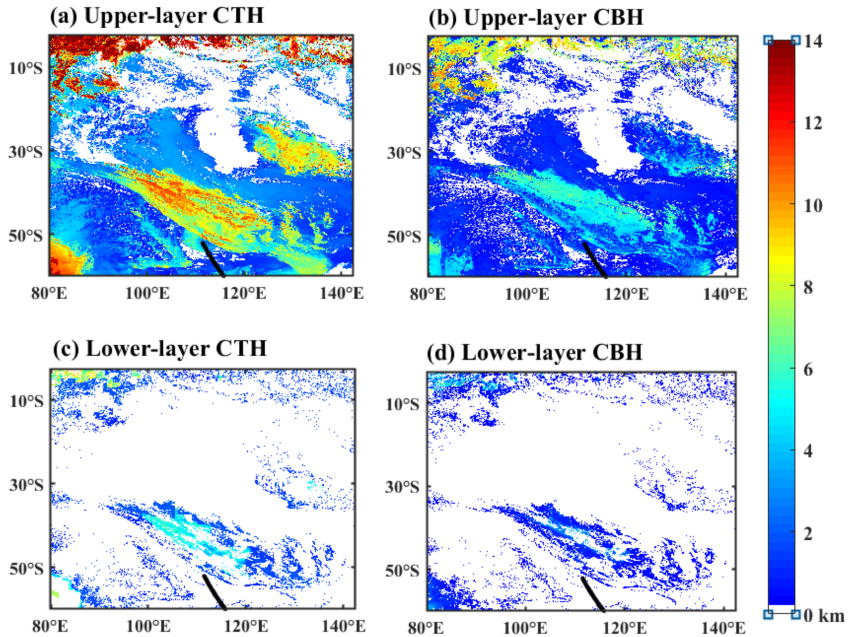
Figure 6. ( a , b ) denote the cloud-top height (CTH) and cloud-base height (CBH) retrievals for upper- layer clouds, and ( c , d ) are for lower-layer clouds at UTC 07:00 on 5 October 2017. Upper-layer clouds include single-layer clouds and the uppermost-layer of multi-layer clouds, while lower-layer clouds only represent the lower layer in multi-layer cloud cases.